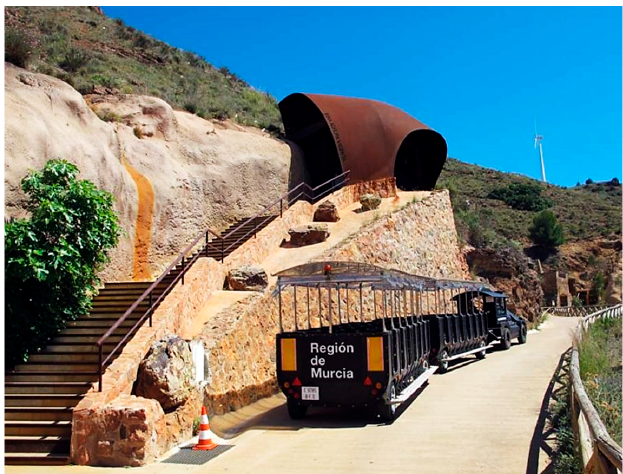
Figure 5. Entrance to the Agrupa Vicenta mine. Municipality of La Unión. Source: Sierra Minera Foundation [34]. Foundation [34].